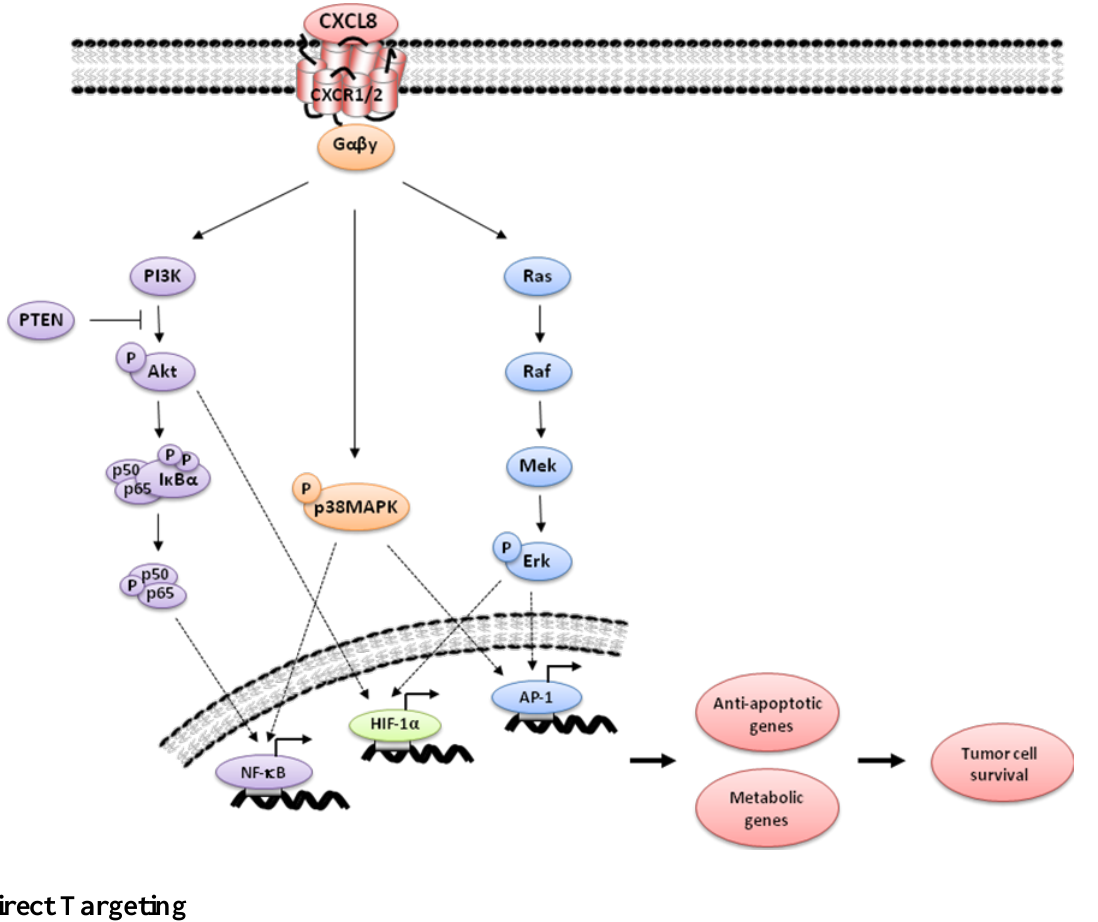
Figure 2. Schematic diagram illustrating the principal signaling pathways activated by IL-8 and their relevance to cell survival. IL-8 induced promotion of NF-κB, HIF-1 or AP-1 transcription factors can increase expression of genes associated with the regulation of apoptosis or cellular metabolism, permitting survival and adaptation in stressful